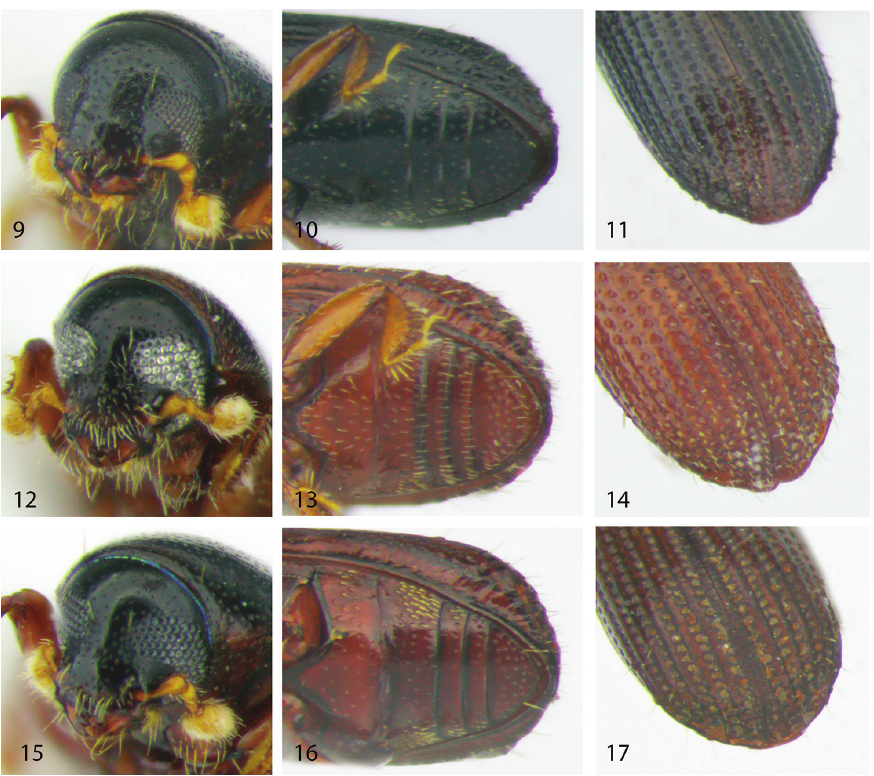
Figures 9–17. Head, venter and declivity of the Afrotropical species of Microborus . 9–11 M. angustatus 12–14 M. brevisetosus 15–17 M. camerunus. Microborus brevisetosus Jordal, sp. n.